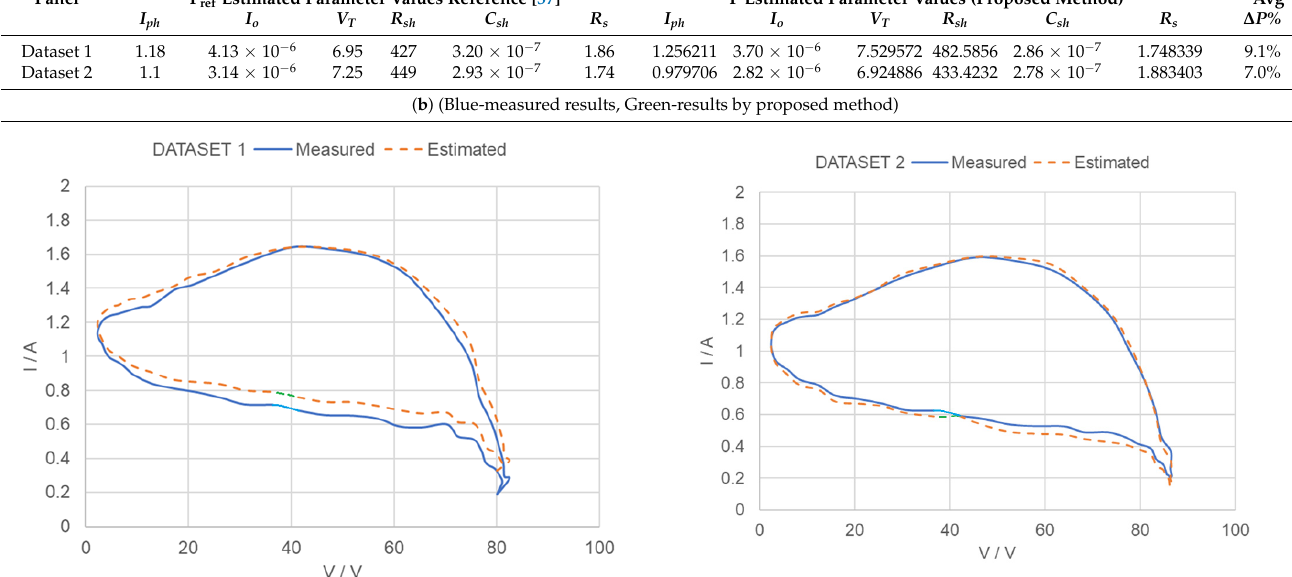
Table 4. Testing of proposed method by experimental data in [37]. ( a ) Summary of Reference parameters in [37] and Estimated Model Parameters by proposed method. Comparisons between estimated model parameters in [37] and the model parameters estimated by proposed method with experimental data in [37] used as input. (Dataset 1) High temperature condition—the lights are turned ON for 2 min and the panels are heated up. (Dataset 2) Low temperature condition—the lights are just turned ON and the panels are still cool. * Avg ∆ P% = Average discrepancies between P ref and P. ( b ) Measure VI curve and estimated VI curve by proposed method. P Estimated Parameter Values (Proposed Method) * Avg I o V T R sh C sh R s I